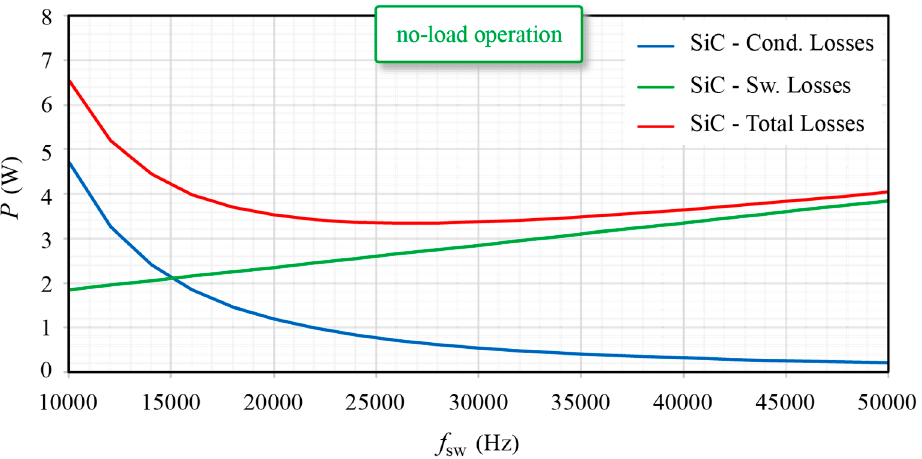
Figure 13. SiC–MOSFET loss optimization due to the adaption of switching frequency during no-load operation.